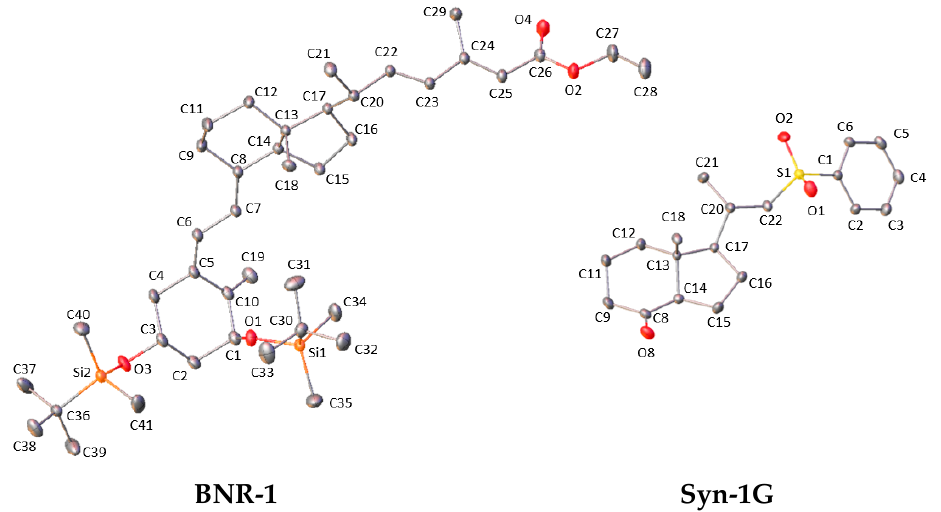
Figure 6. Displacement ellipsoids (50% probability level) of the molecular structure obtained with the MM refinements of BNR-1 and Syn-1G. H-atoms were omitted for clarity.